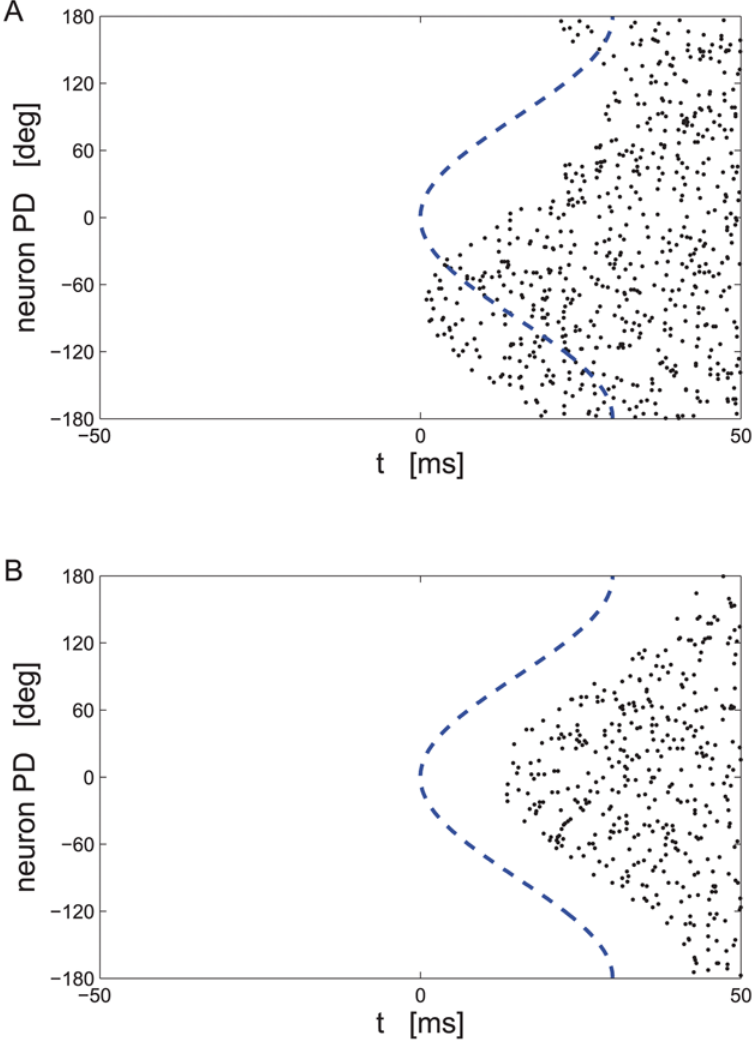
Figure 8. Simulation of a hypercolumn population raster in the presence of correlations. Spiking responses of 360 cells coding for an external stimulus h ~ 0 0 during a single trial are shown. Every line shows the spike-times of a single cell. The cells are arranged according to their preferred directions. Spike times are distributed as defined in the section ‘effect of correlations on tWTA accuracy’, see equation (34), with r ~ 50 Hz and t Q ð Þ ~ 15 1 { cos Q ð Þð Þ ms . For the correlated part: (a) t c ~ 10 ms , t ~ 0 ms ; (b) t c ~ 0 ms , t ~ 10 ms . The dashed line shows t w { h